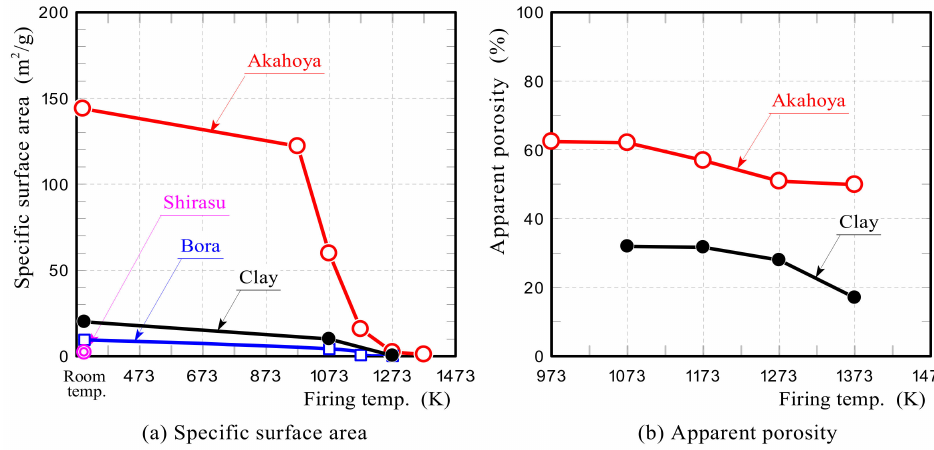
Figure 9. ( a ) Specific surface area and ( b ) apparent porosity of samples.